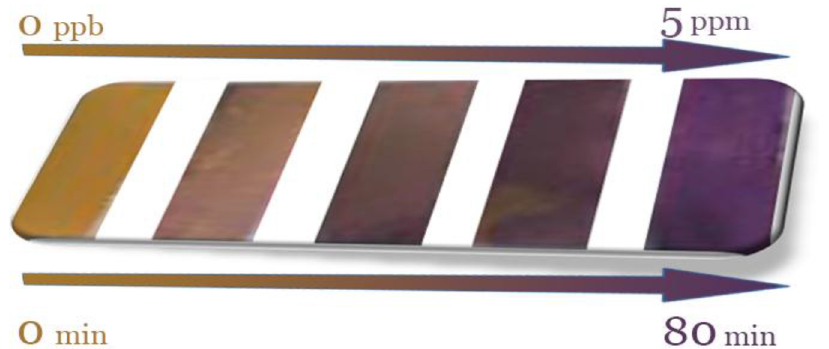
Fig. 1. Schematic of colorimetric